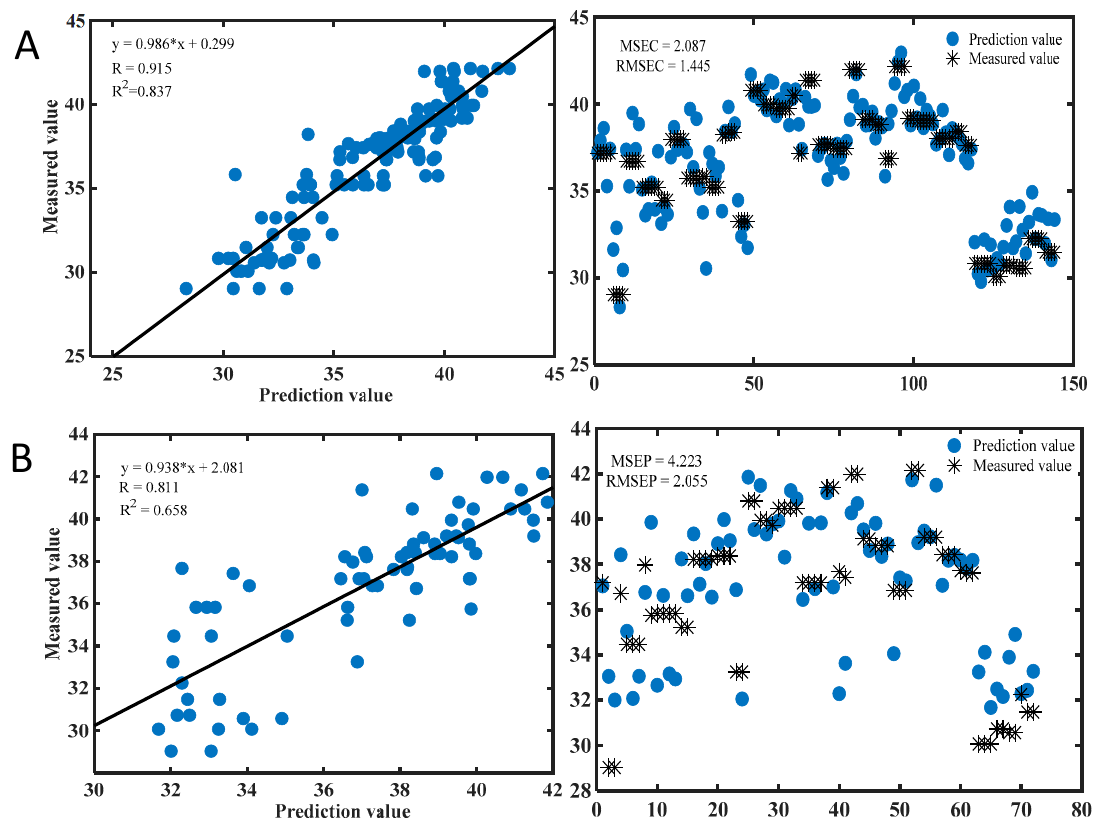
Figure 8. The performance of S-G-VCPA-CNN model: ( A ) is calibration set; ( B ) is prediction set.